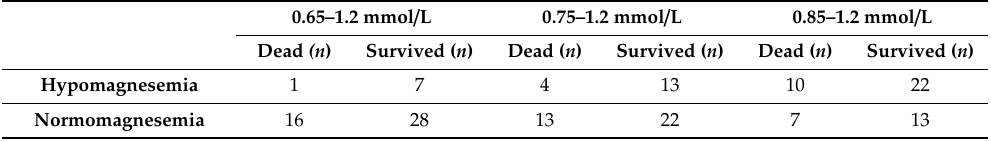
Figure 6. Variation in magnesium concentration in group of patients who were examined at least 10 times and whose hospitalization resulted in ( A ) death or ( B ) survival. Figures A and B present variations in magnesium concentration of ten subjects from each group, in which these fluctuations were expressed the most. The value of magnesium variation was expressed as a di ff erence between the lowest and the highest serum Mg concentration during hospitalization. ( C ) The di ff erence between these two groups assessed with Mann–Whitney test (death, n = 17 and survival, n = 35) was statistically significant ( p = 0.0017). Table 2. Number of patients ( n = 52) tested at least 10 times who died ( n = 17) or survived hospitalization ( n = 35) with regard to their magnesium status. Data are separately presented for di ff erent lower cut-o ff for reference magnesium concentration in